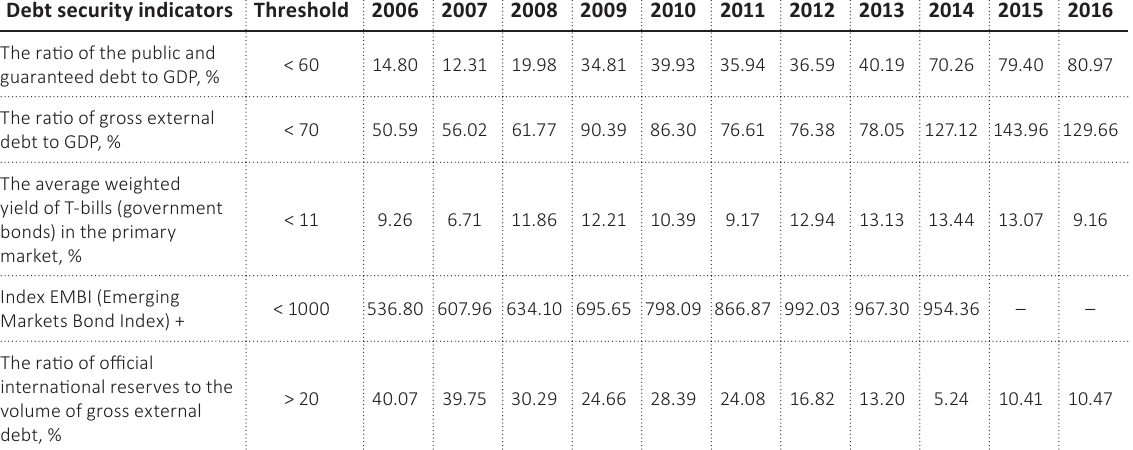
Source: Compiled by the